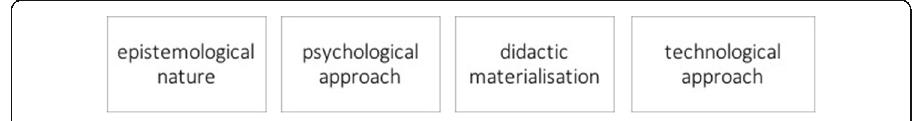
Fig. 1 Key elements that characterise educational implementation. Source: Own